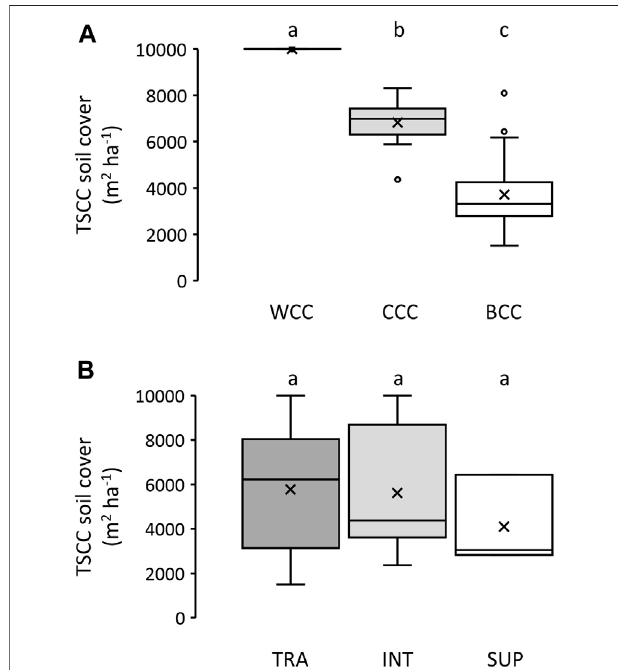
FIGURE 3 | Box and whiskers plot of soil covered by TSCC for each of the cover crop layout (A) and tree density (B) . Horizontal black line, x-shaped cross, box borders and whiskers stand for the median, the mean, quartiles and outliers. Different letters over the box-plot indicate signi fi cant differences ( p < 0.05). WCC, CCC and BCC stand for olives groves where TSCC occupied the whole area, was absent under tree canopy or only occupied a strip of the inter-row area, respectively. TRA, INT and SUP stand for olive grove with a traditional, intensive and superintensive tree density.